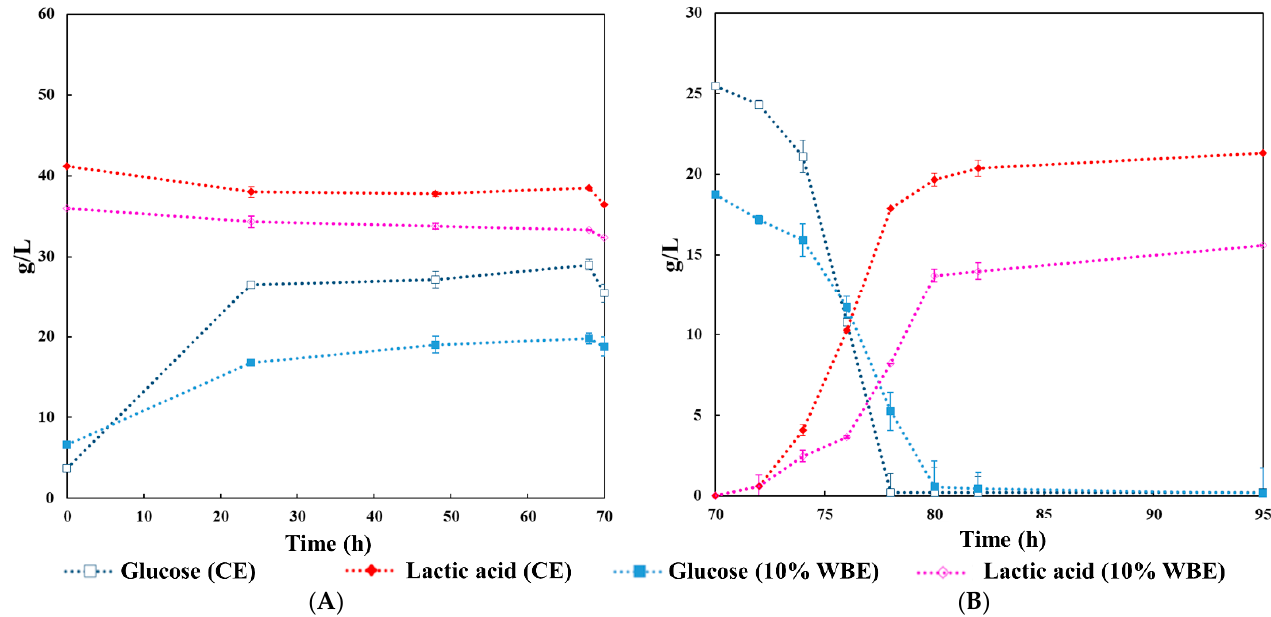
Figure 4. Hydrolysis and subsequent fermentation of OFMSW. ( A ) The graph illustrations the variation in the concentration of glucose and lactic acid during hydrolysis. ( B ) Glucose consumption and lactic acid production during lactic acid fermentation. CE–commercial enzymes; WBE–wheat bran rich in enzyme via SsF.